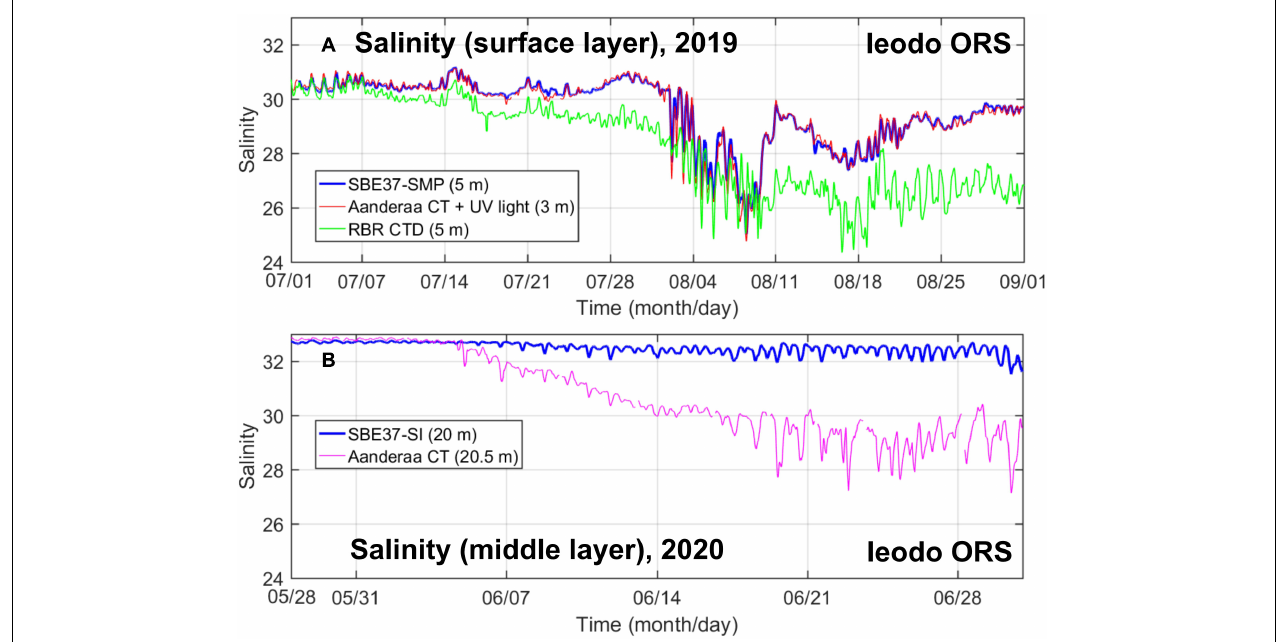
FIGURE 9 | Comparison of Ieodo ORS salinity data time-series measured: (A) in surface layers by a SBE37-SMP (5 m), an Aanderaa CT with UV light sensor (3 m), and a RBR concerto CTD (5 m), from July to August, 2019; and (B) in the middle layers by a SBE37-SI (20 m) and Aanderaa CT (20.5 m), from May 28 to June 30, 2020. Note that the salinity drop during early August 2019 shown in panel (A) was due to the summertime inflow of Changjiang River Diluted